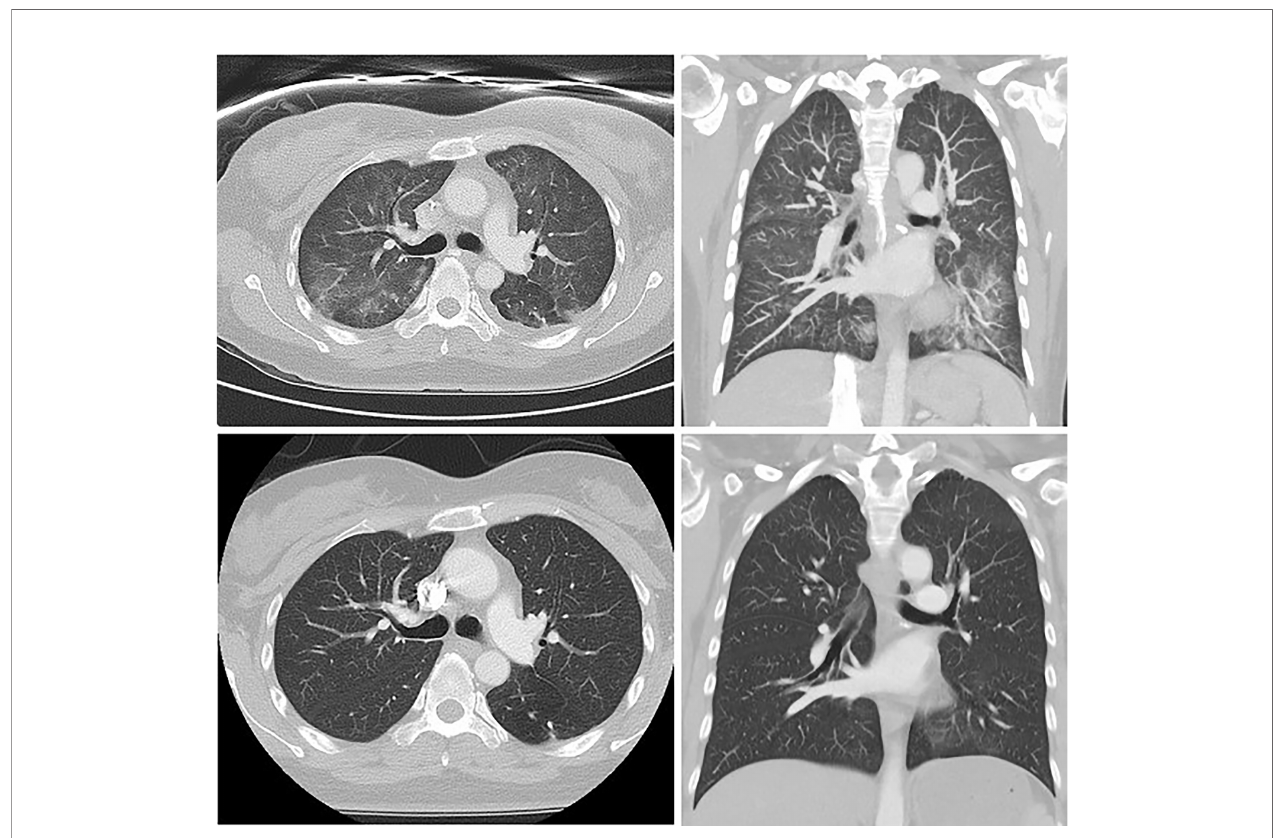
FIGURE 2 | Thoracic HRCT from patient 4, demonstrating interstitial fi brosis, increased reticular markings, ground glass attenuation and traction bronchiectasis at the time of diagnosis (above) and subsequent standard-resolution thoracic CT showing resolution of these changes following 6 weeks of corticosteroids